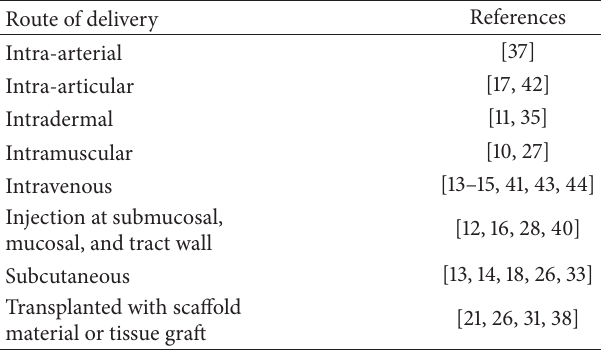
Table 4: Comparison on reporting of data on cell characteris- tics between papers grouped prior to and after publication of IFATS/ISCT statement on